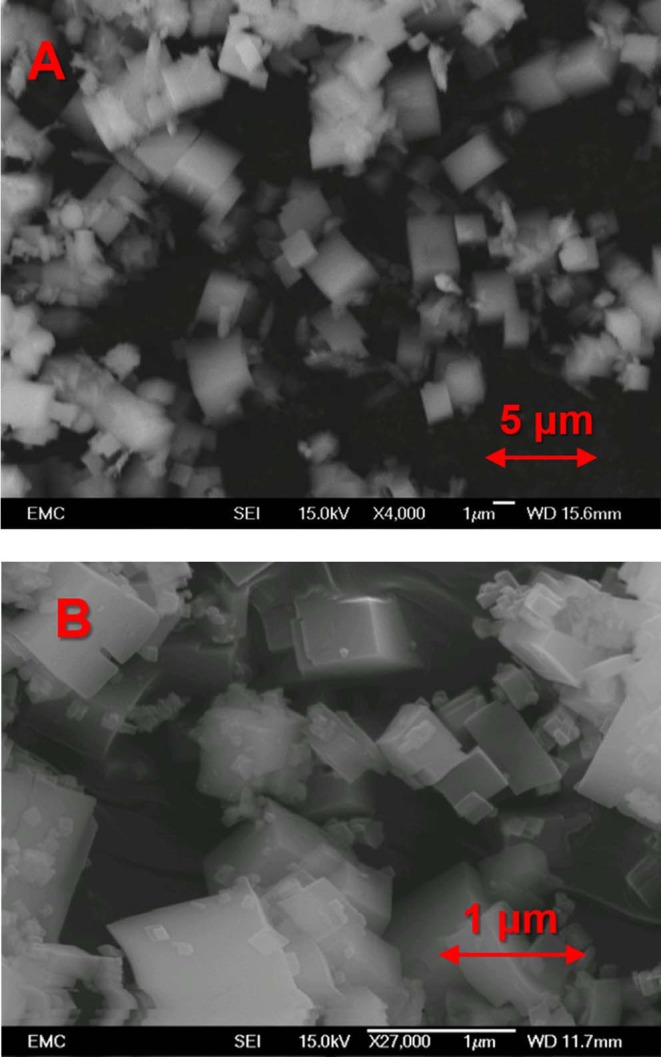
SEM images of (A) MgSAPO-34 and (B) SAPO-34, both showing predominantly cubic crystals of 1–2 μm in size in both cases.